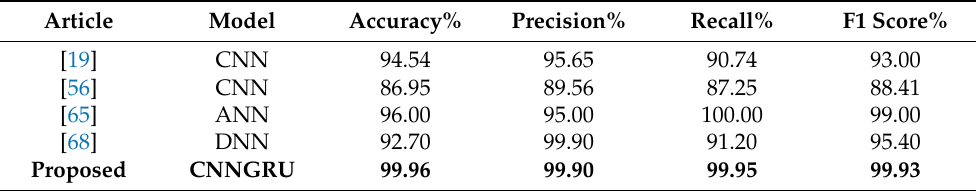
Table 13. Binary classification comparison.